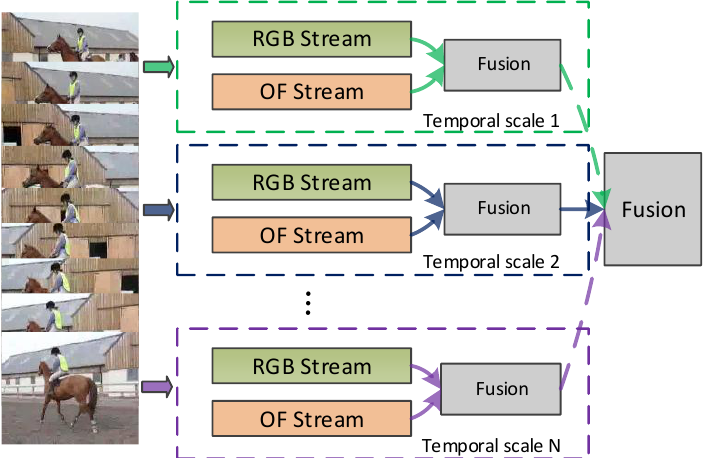
Figure 1. The framework of our proposed method.